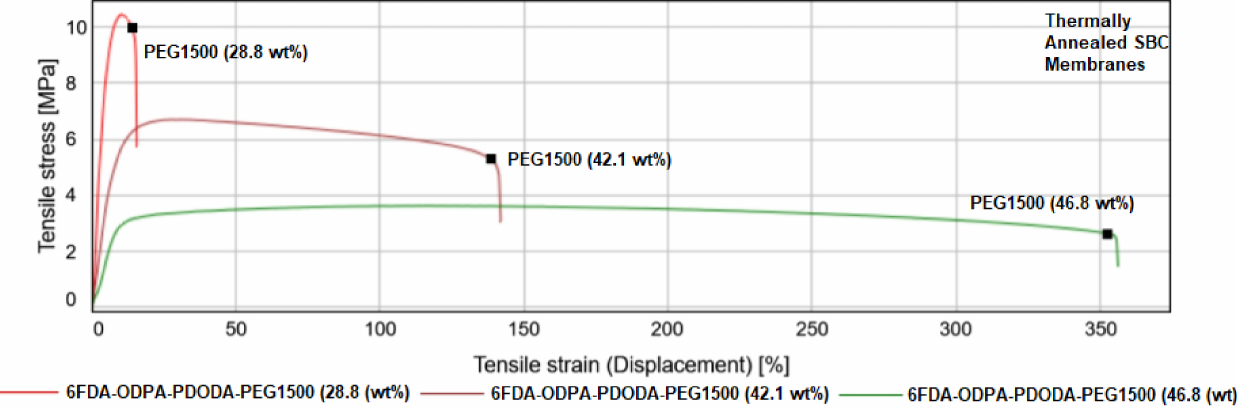
Figure 5. Stress–strain curves obtained from the tensile test for 1 h thermally treated SBC membranes with changing PEG1500